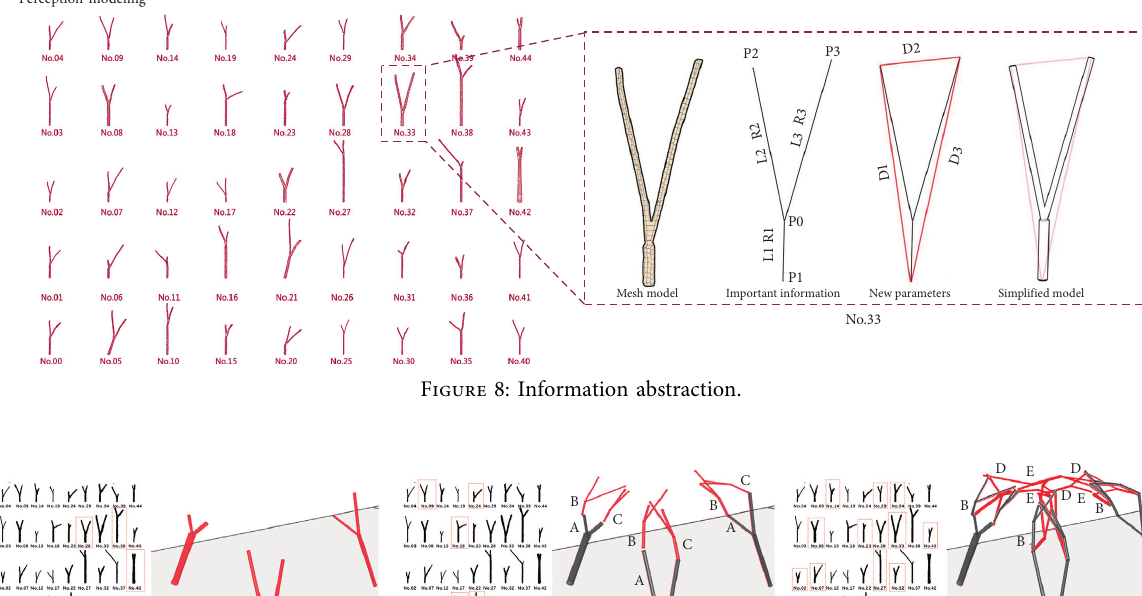
Figure 9: Computational generation